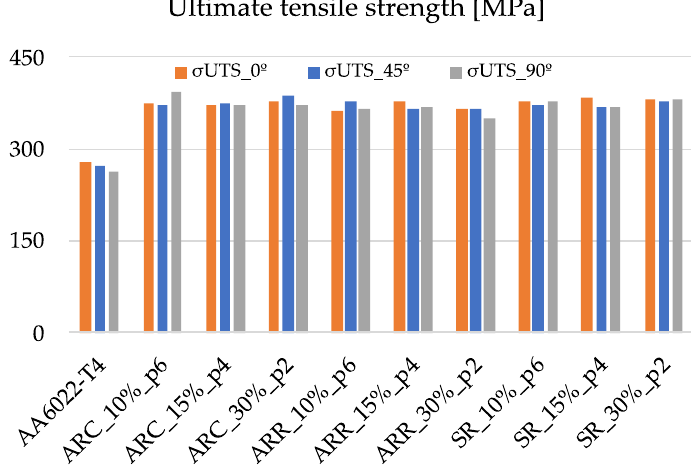
Figure 7. Evolution of the ultimate tensile strength with rolling conditions.